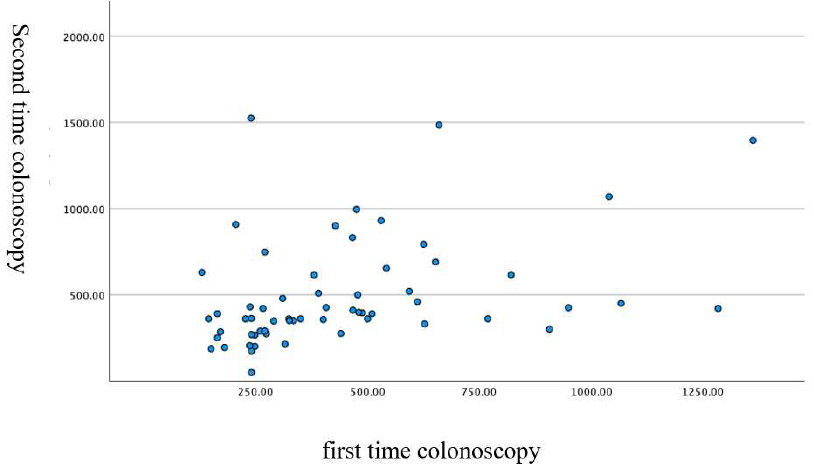
Figure 5. Correlation of the time taken from the anus to the splenic flexure in the first and the second colonoscopies (scatter plot). Pearson correlation coefficient: 0.374. p < 0.03 two-sided test.